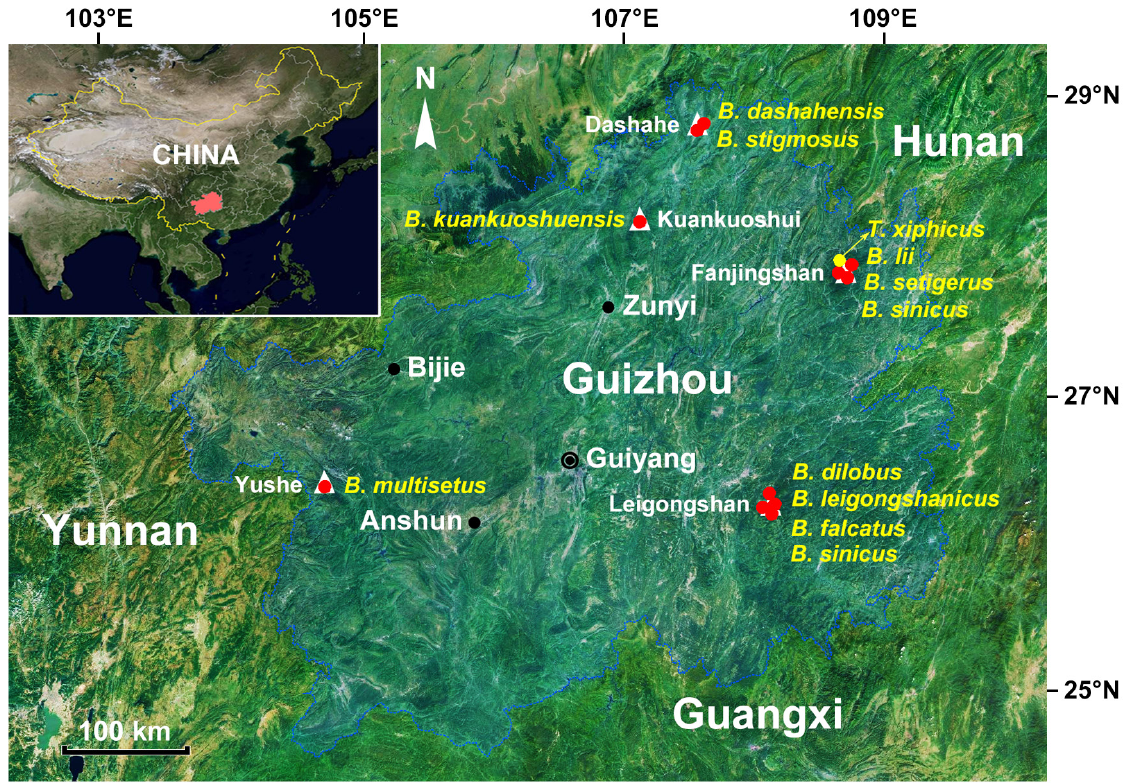
Fig. 1. Distribution map for Bittacidae Handlirsch, 1906 in Guizhou,